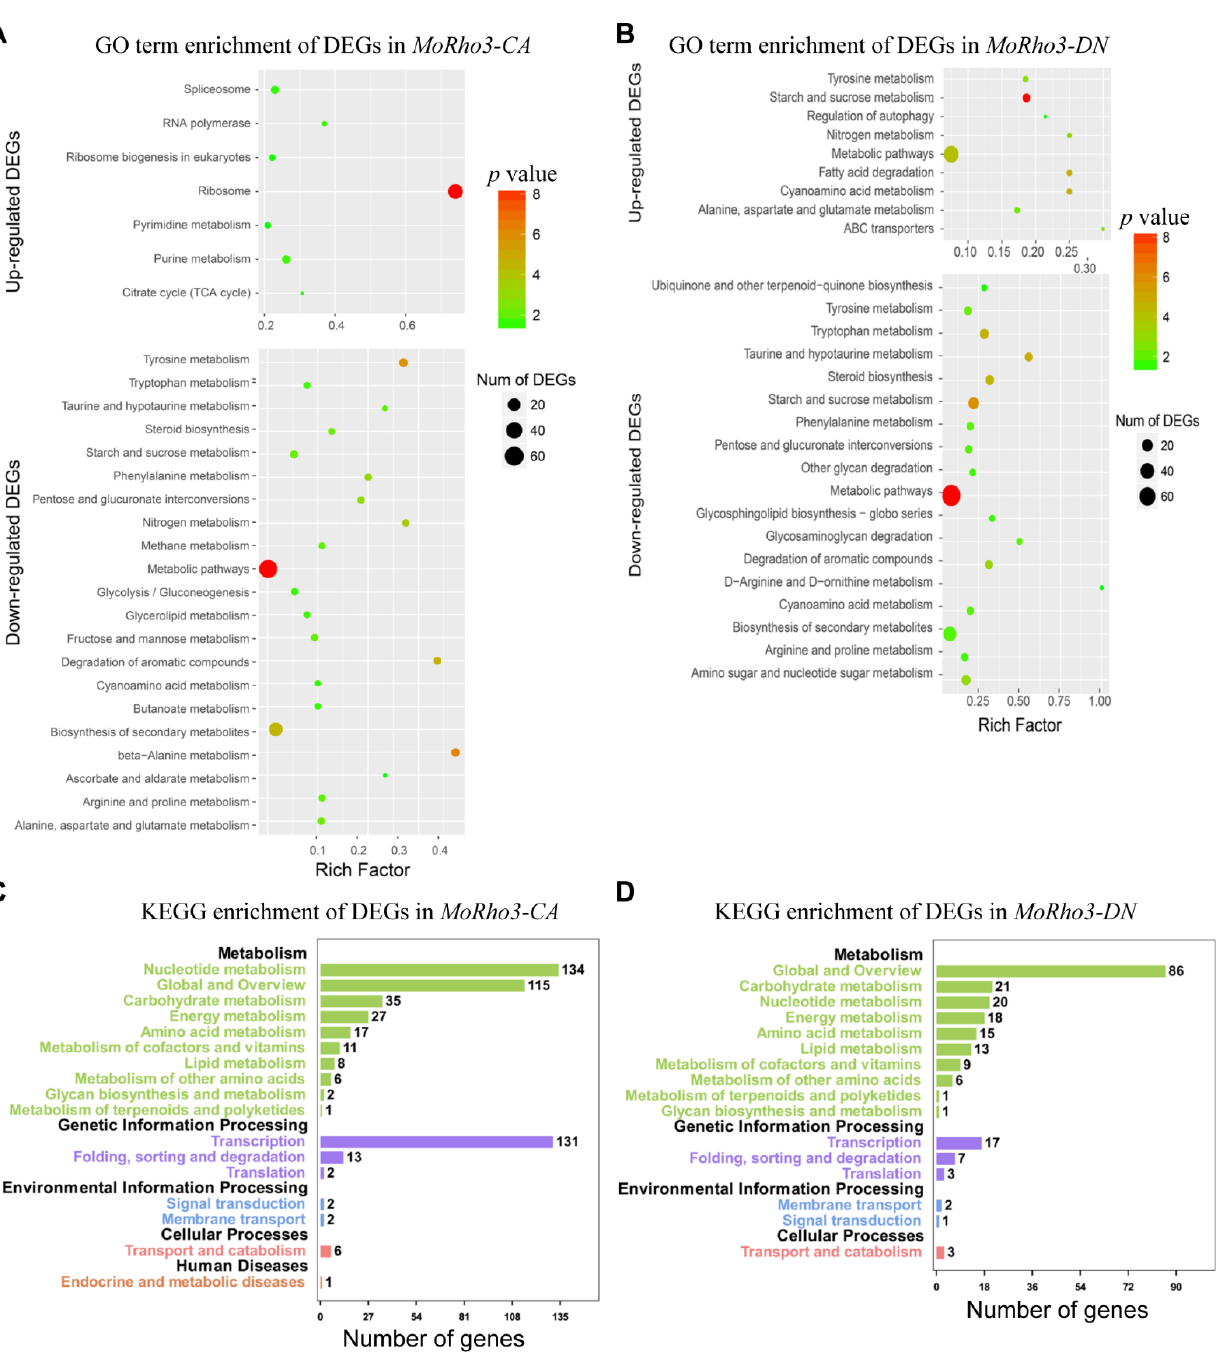
Figure 3. Pathways related to DEGs of CA and DN mutants of MoRho3. ( A ) GO term enrichment of up- and down-regulated genes in MoRho3-CA . ( B ) GO term enrichment of up- and down-regulated genes in MoRho3-DN . ( C ) Statistics of KEGG pathway enrichment of up- and down-regulated genes in MoRho3-CA . ( D ) Statistics of KEGG pathway enrichment of up- and down-regulated genes in MoRho3-DN .